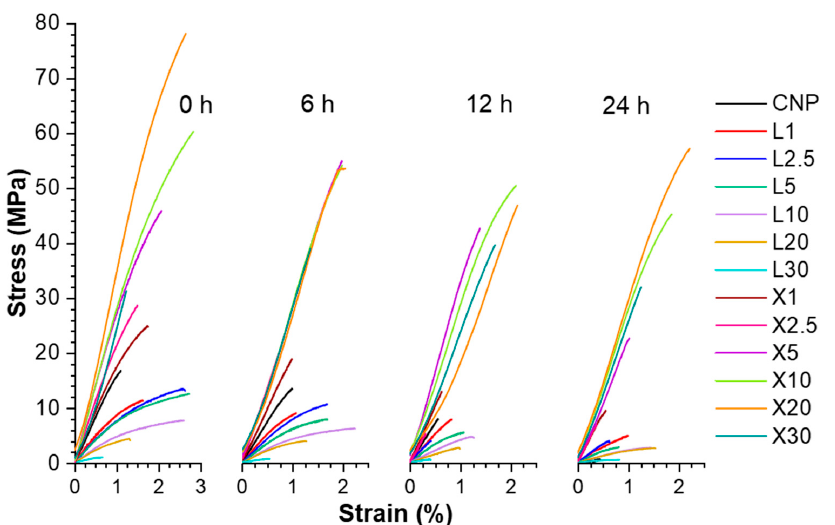
Figure 2. Representative stress–strain curves of NP for pristine and aged samples at different times of UV irradiation at 80 °C temperature. Lignin (L) and xylan (X) with their loading in wt%. E.g., X1 sample corresponds to NP with 1 wt% xylan and 99 wt% NFC loadings, L1 sample—lignin 1 wt% and NFC 99 wt%.